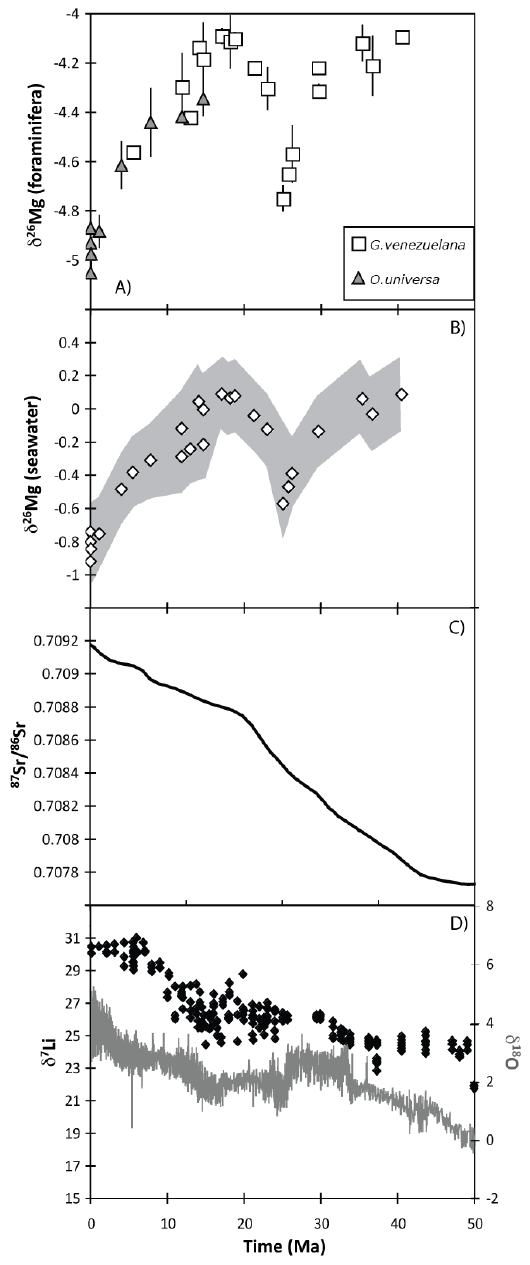
Figure 4. (a) Foraminiferal δ 26 Mg values from the past 40Myr. Un- certainty on the age model is smaller than the symbol size. The error bars represent the 2SD analytical reproducibility of the individual samples. (b) Reconstructed seawater δ 26 Mg from the foraminiferal record. The grey band shows the extent of uncertainty, including an- alytical uncertainty and scatter due to the spread in modern O. uni- versa and the offset between the two analysed species ( ± 0 . 28‰). (c) LOWESS Cenozoic Sr isotope data (McArthur et al., 2001) (d) Li (Black diamonds) and O (grey line) isotope ratios of plank- tonic foraminifera (Misra and Froelich, 2012; Zachos et al.,